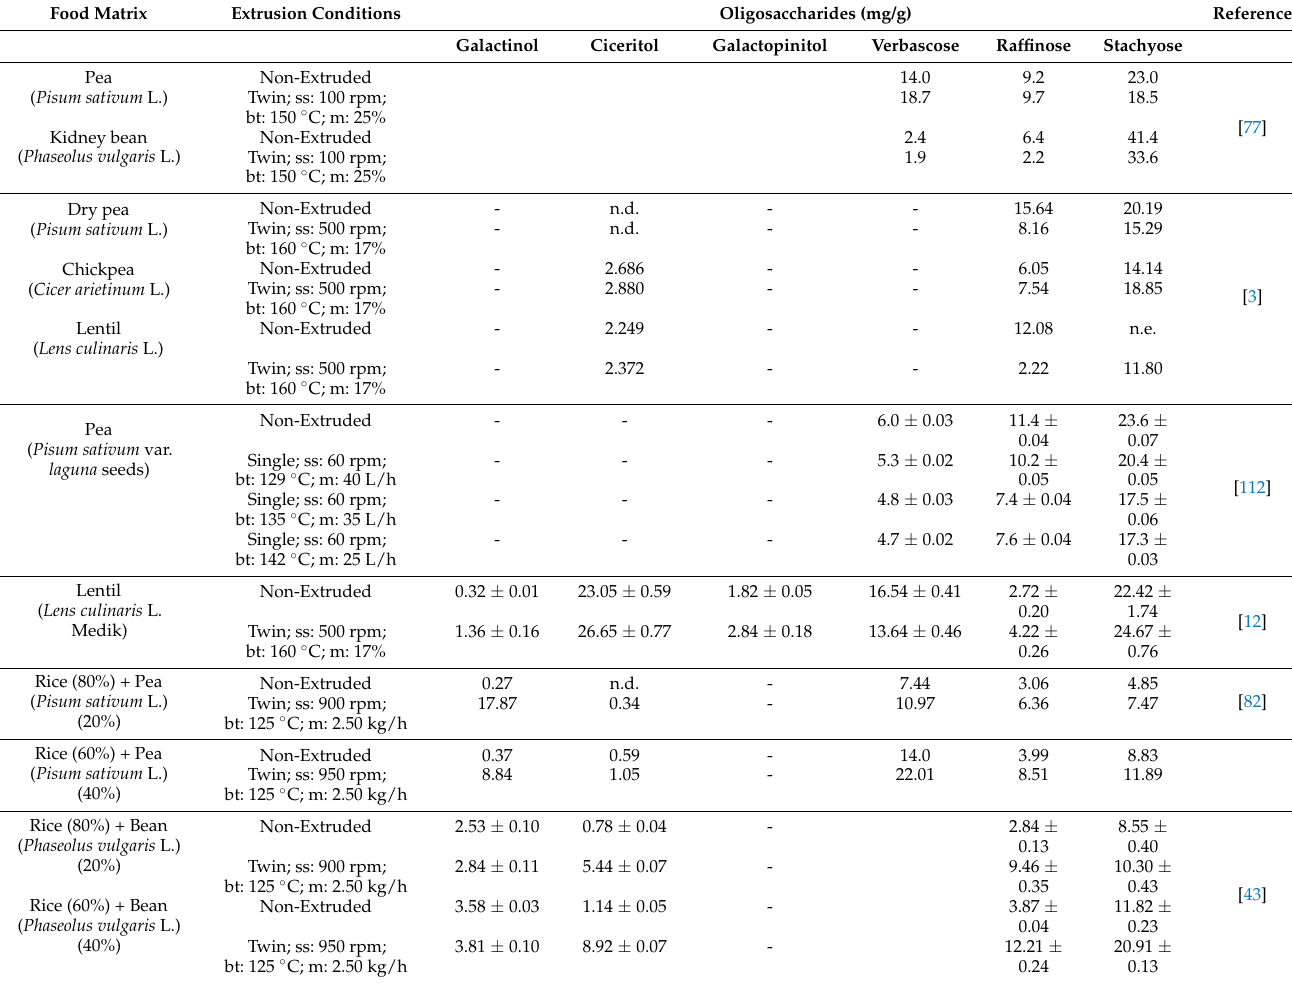
Table 4. Effect of processing conditions on oligosaccharides content in pulse